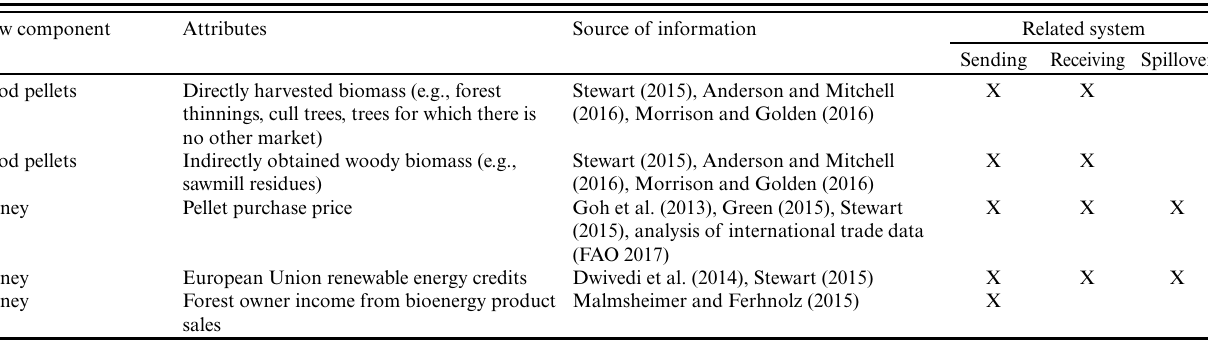
Table 2. Flow components of the telecoupled transatlantic wood pellet trade system. Xs indicate the systems (Table 1) that are most closely related to each component